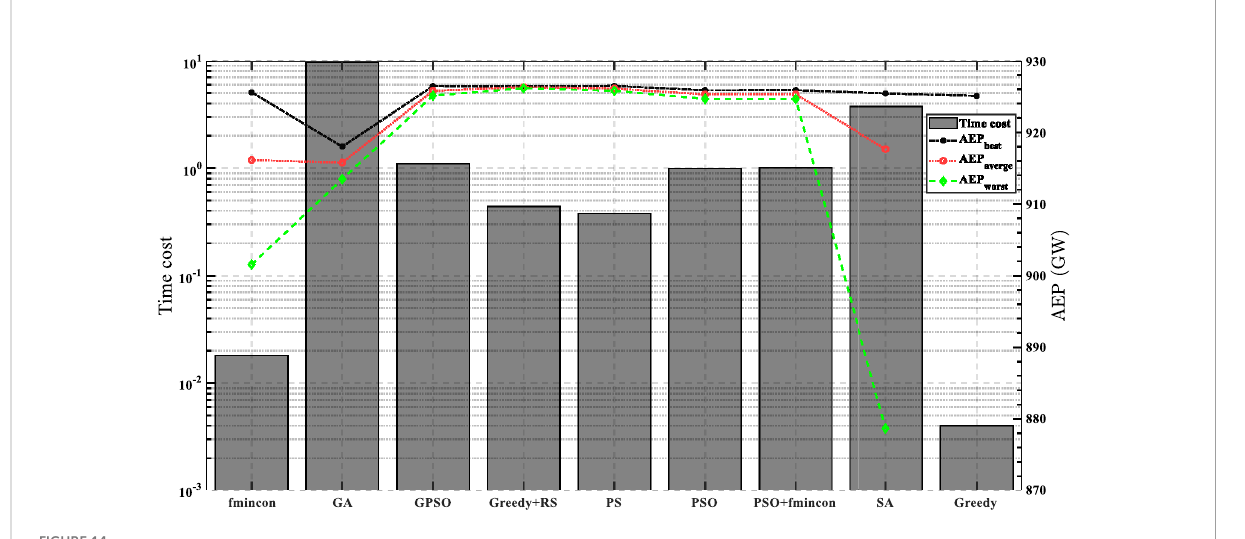
FIGURE 14 Time cost versus AEP with different optimization